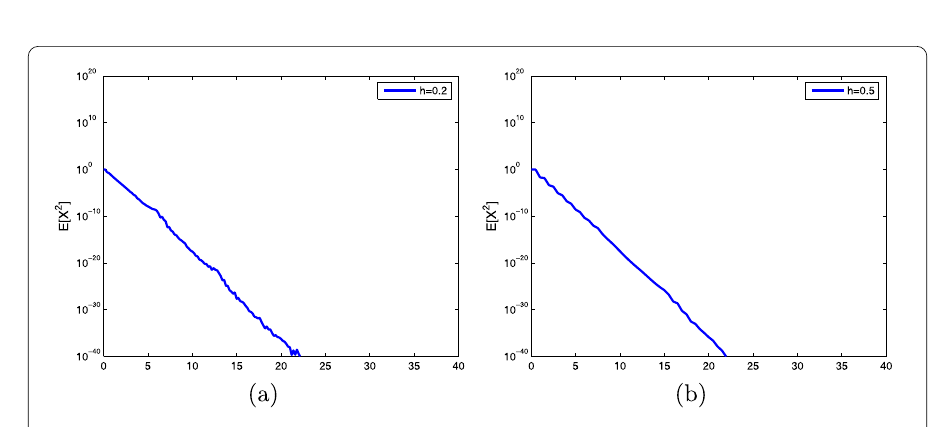
Figure 3 The exponential Euler method with h 1 = 0.2, h 2 =